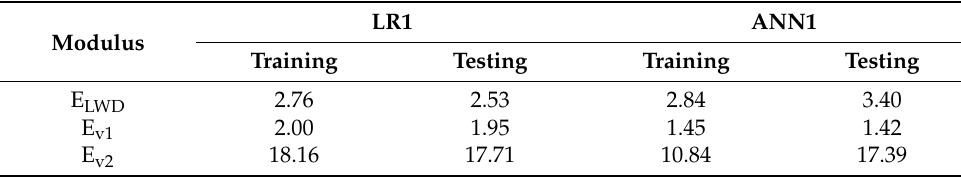
Table 4. Root mean square error (RMSE) results for ANN1 and LR1.